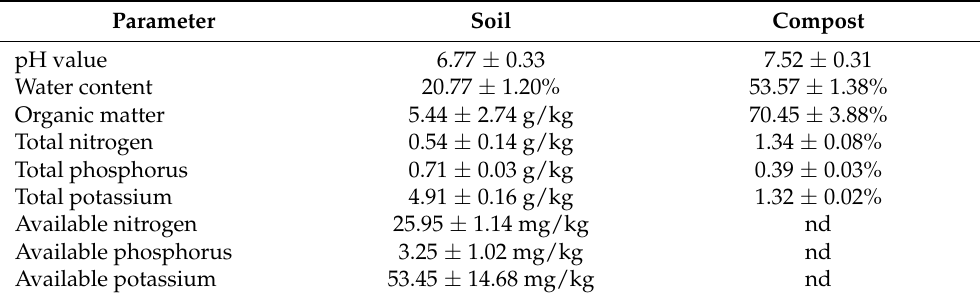
Table 2. Physio-chemical composition of the compost and soil prepared for the Agaricus subrufescens glasshouse